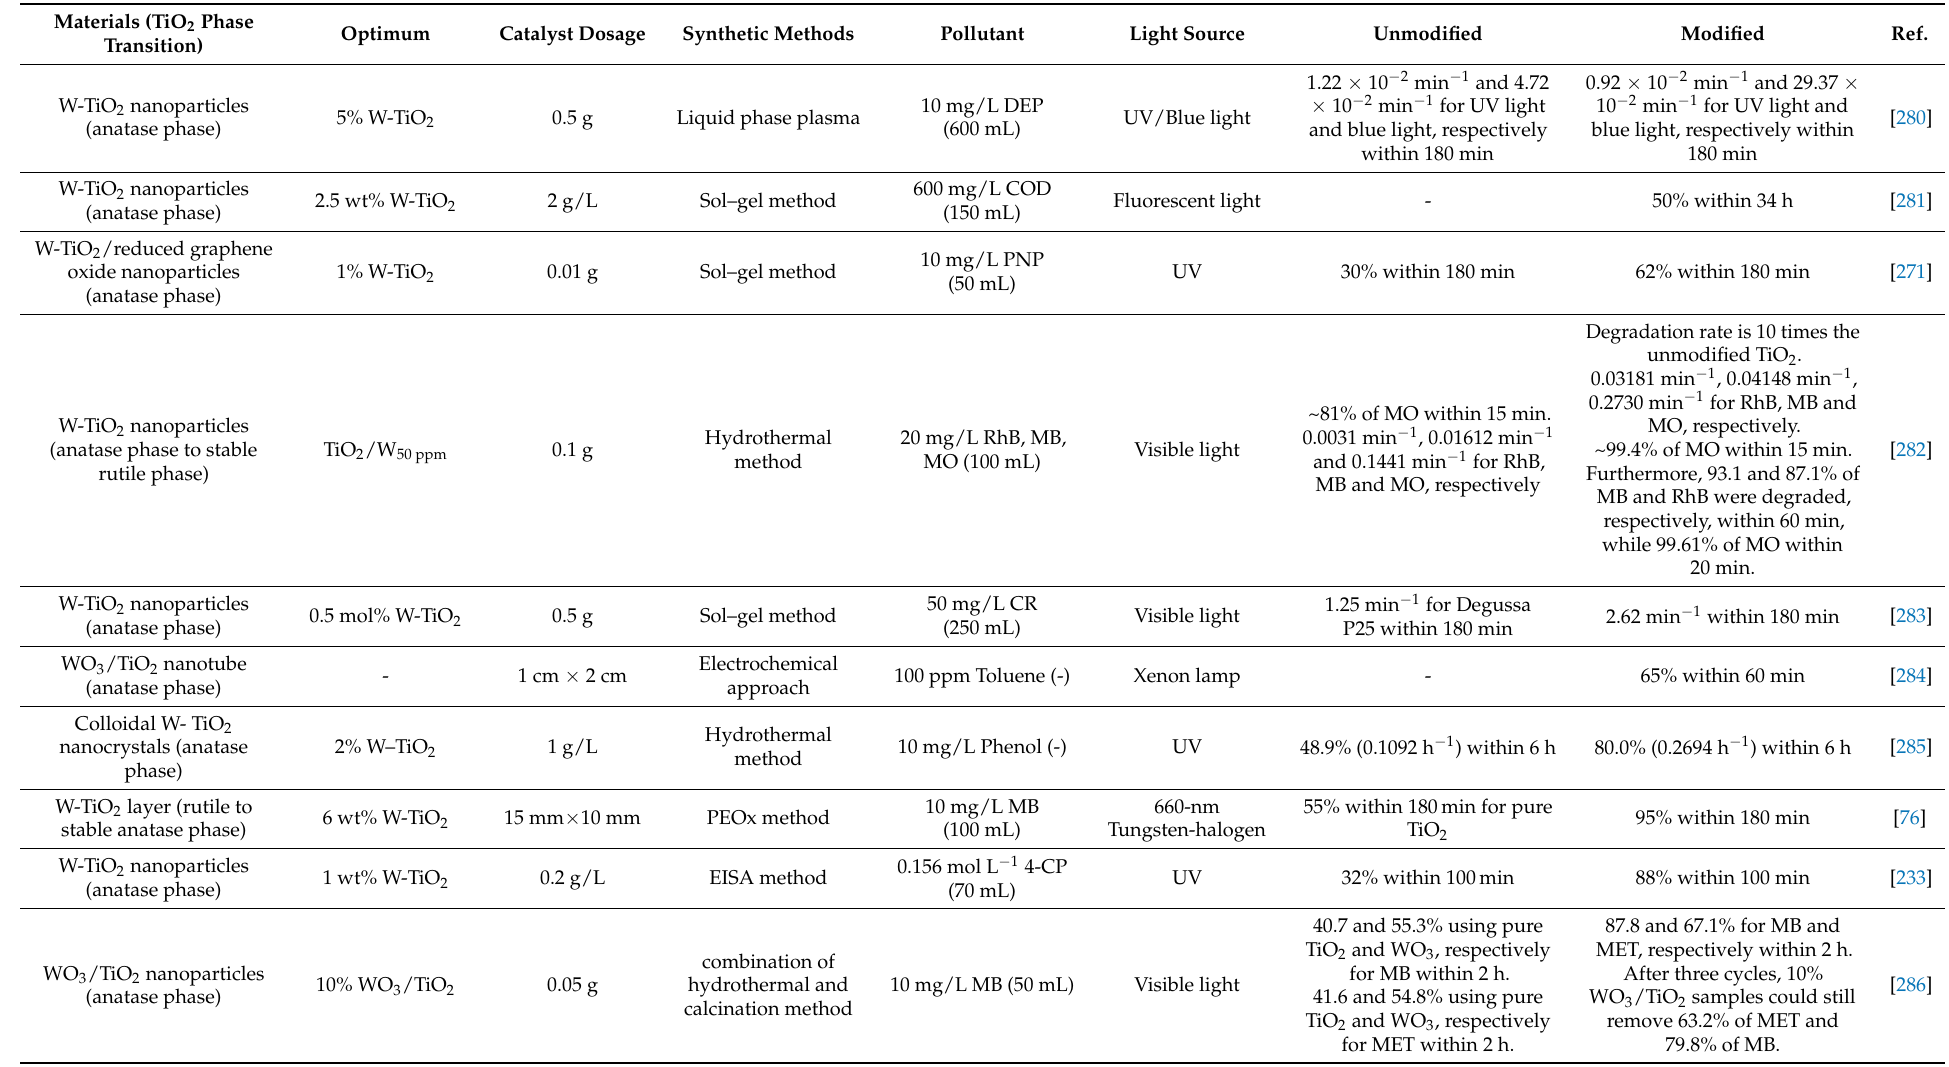
Table 13. Summary of recent progress on W-TiO 2 photocatalysts for organic pollutants